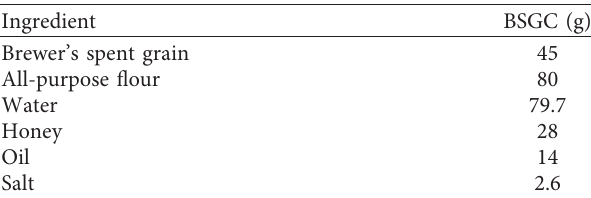
Figure 1: Brewer’s spent grain flour preparation. Table 1: Ingredients used in the brewer’s spent grain chips